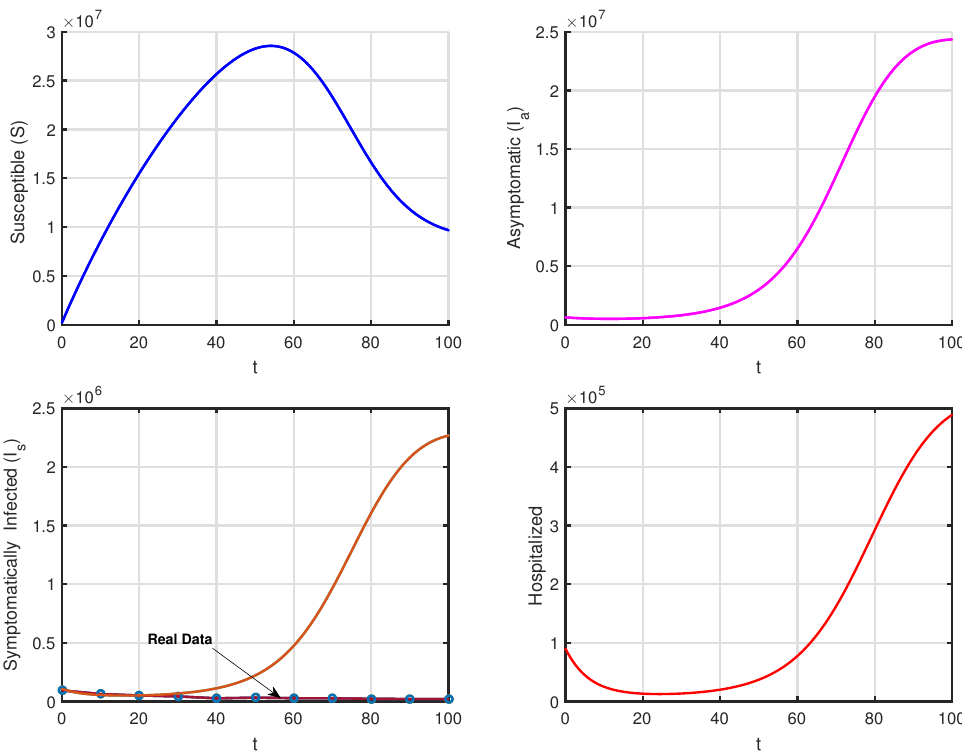
Figure 1. Time series of S , I a , I s , H of system (1) for 100 days from 1 January 2022 to 10 June 2022 when no government control is applied ( α = 0), corresponds to Table 1.